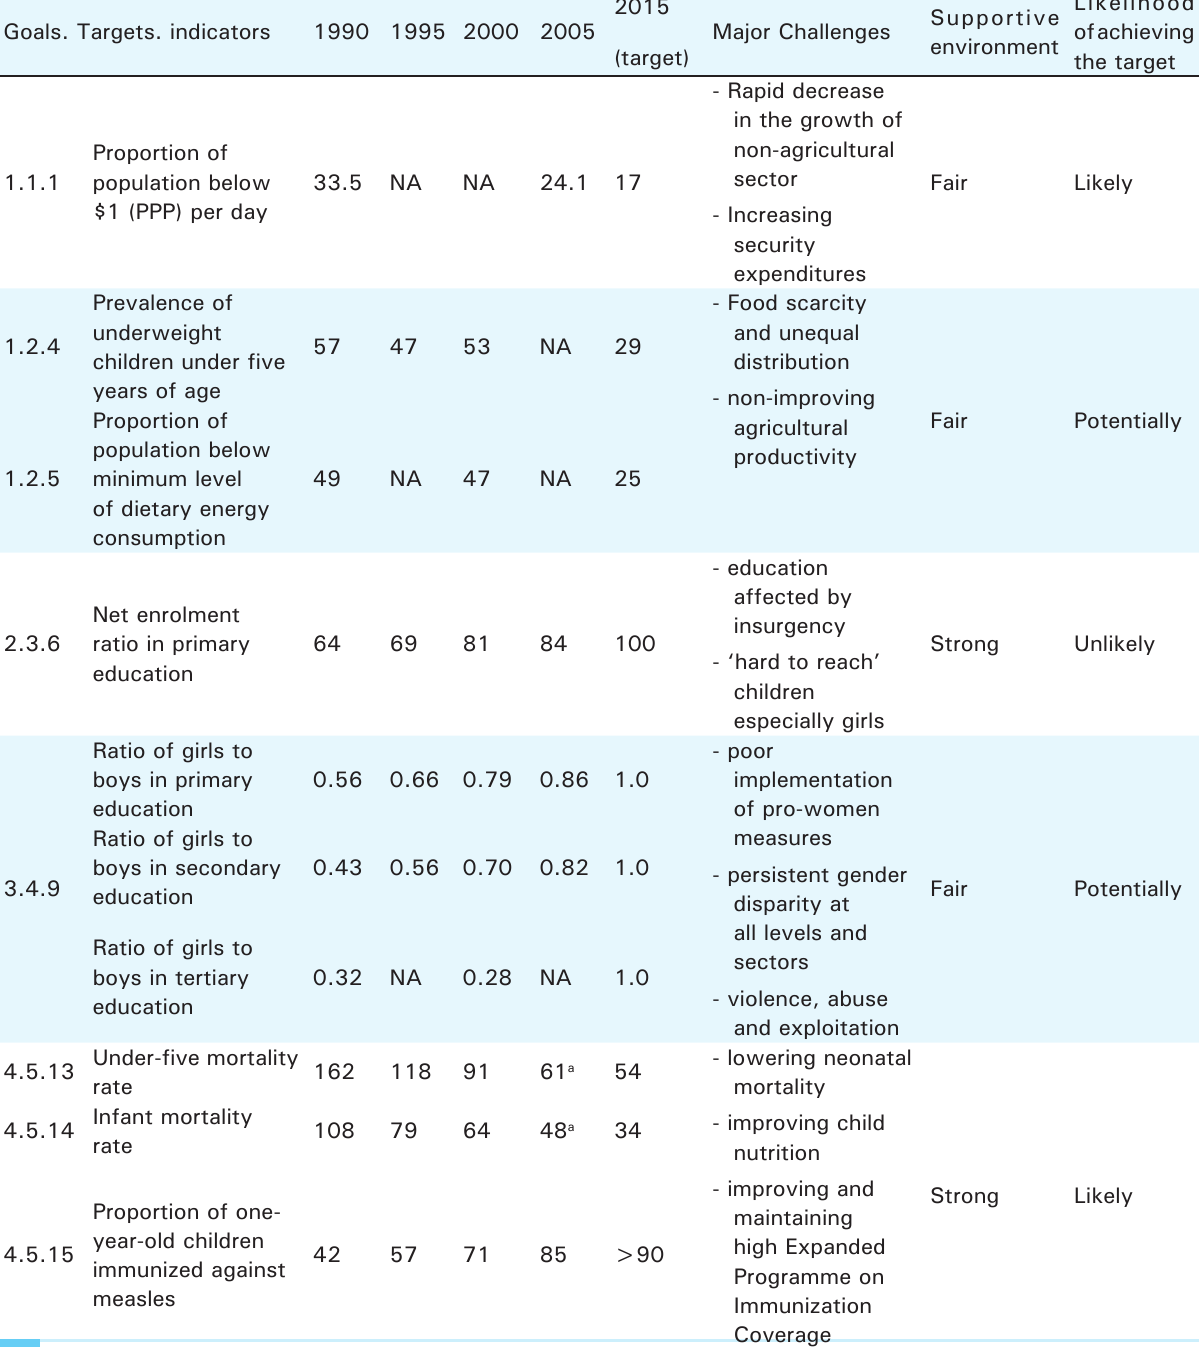
table 2. nepal’s indicators in health and health-related MDGs, challenges and likelihood of achieving them 6